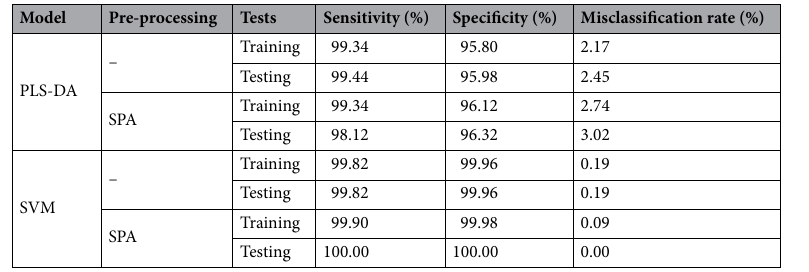
Table 6. Summary of the quality statistical parameters of PLS-DA and SVM model (transverse